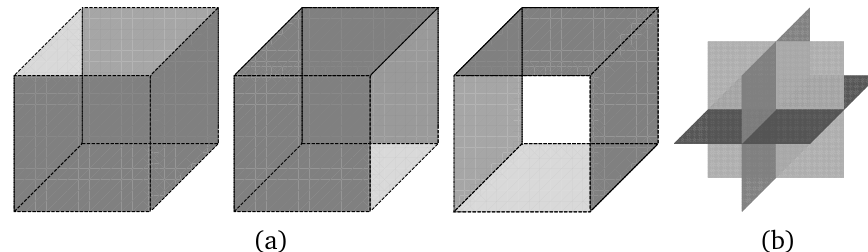
Figure 2: (a) The term L [ , L [ , L [ in the Hamiltonian, which are products x y ] z zx ] y yz ] x of the U ’s on the plaquettes. (b) Gauss law constraint G , which is a products of 12 V ’s on the plaquettes. The shaded faces stand for U and V on the plaquette in (a) and (b), respectively. We suppress the orientation of these plaquette